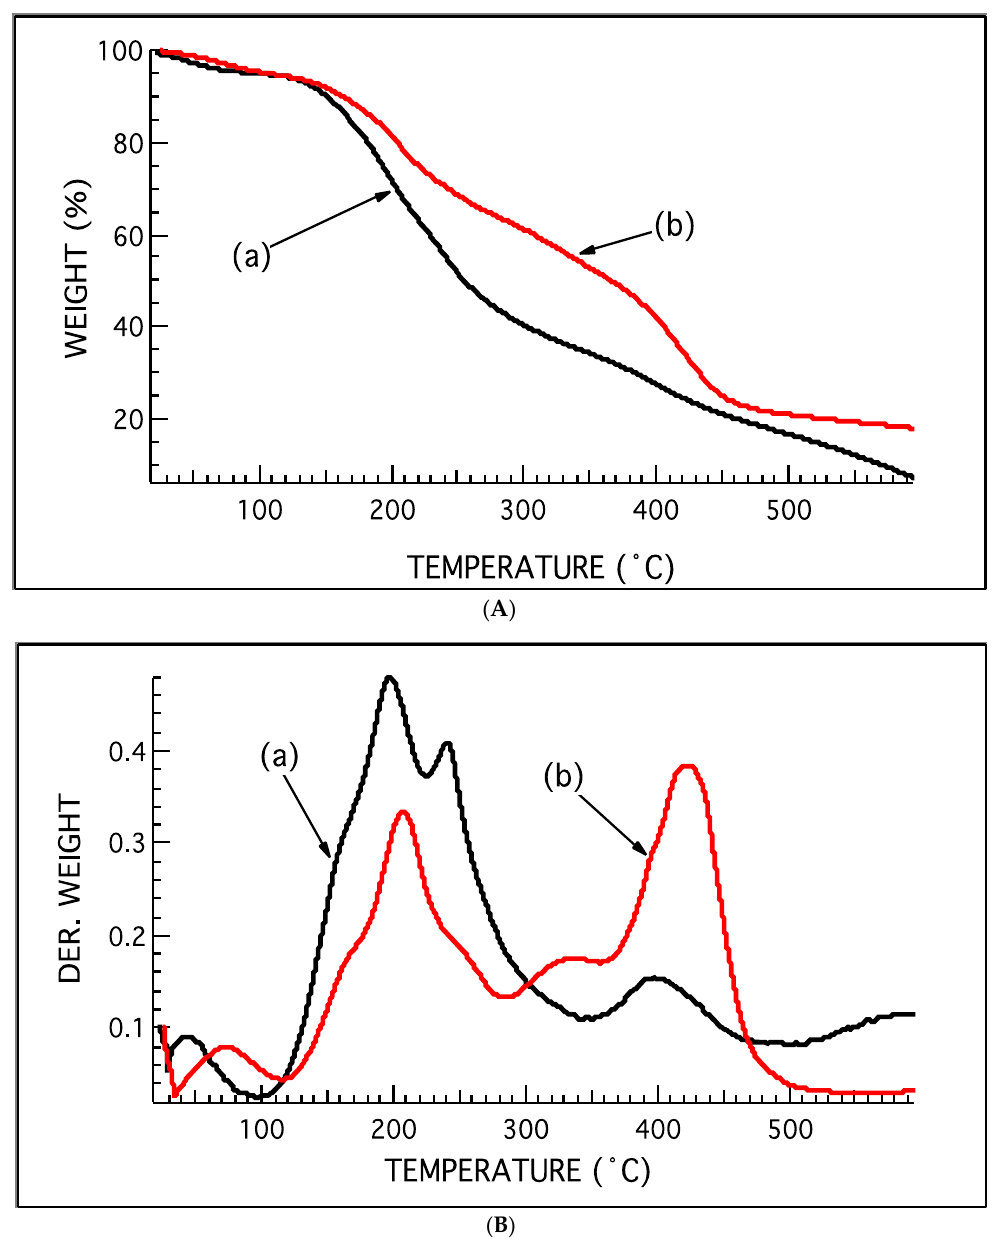
Figure 4. ( A ) Comparison of percent weight as a function of temperature for microcapsules with 22% free formaldehyde shell:core ratio 1:2 and varying water:oil ratios. (a) W:O = 6:1; (b) W:O = 6.5:1. ( B ) Comparison of derived weight as a function of temperature for microcapsules with 22% free formaldehyde shell:core ratio 1:2 and varying water:oil ratios. (a) W:O = 6:1; (b) W:O = 6.5:1. Yield